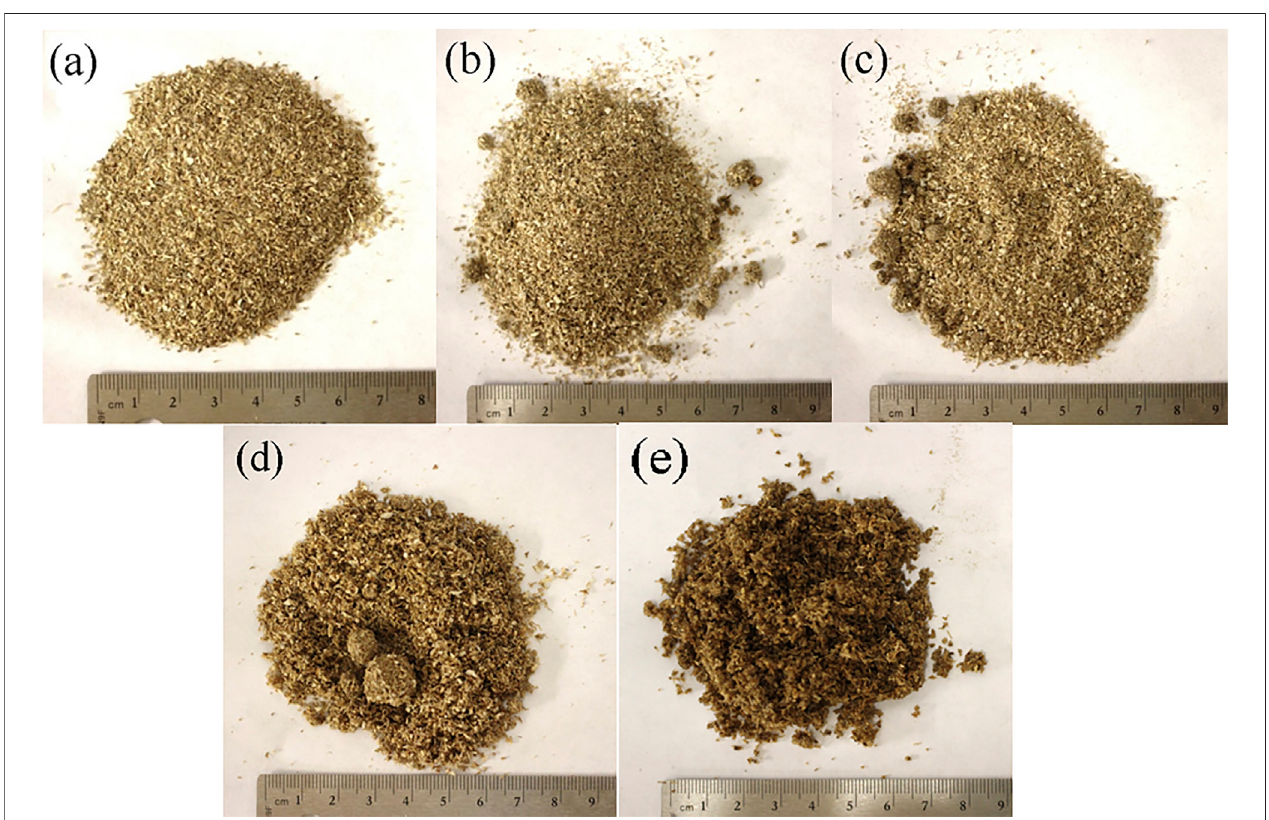
FIGURE1| Imagesofthe (A) dry, (B) 15%moisture, (C) 25%moisture, (D) 50%moisture,and (E) 75%moistureAsamples.Therulerisincludedineachimagefor scale.